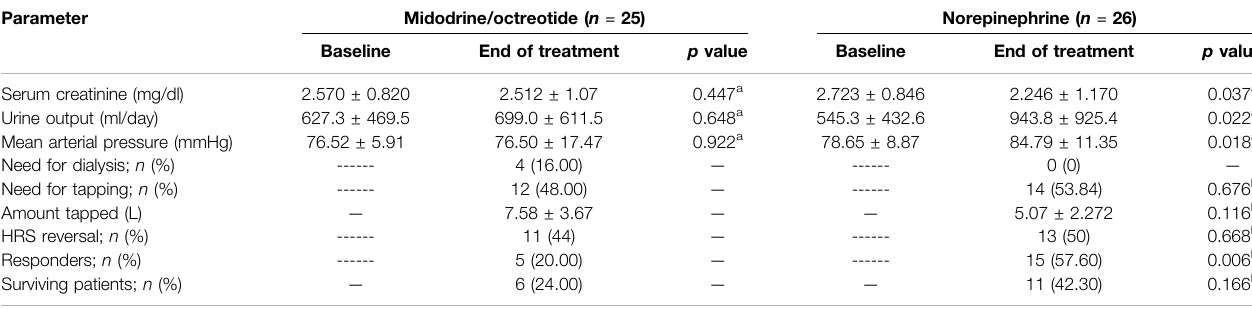
TABLE 2 | Change in parameters with therapy in the two study groups.